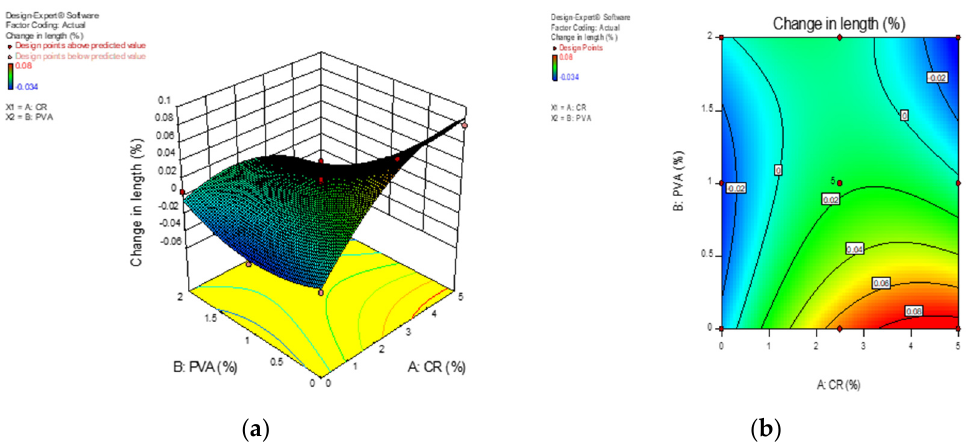
Figure 10. Response surface diagram for change in length due to sulphate attack. ( a ) 3D surface diagram; ( b ) 2D contour plot.